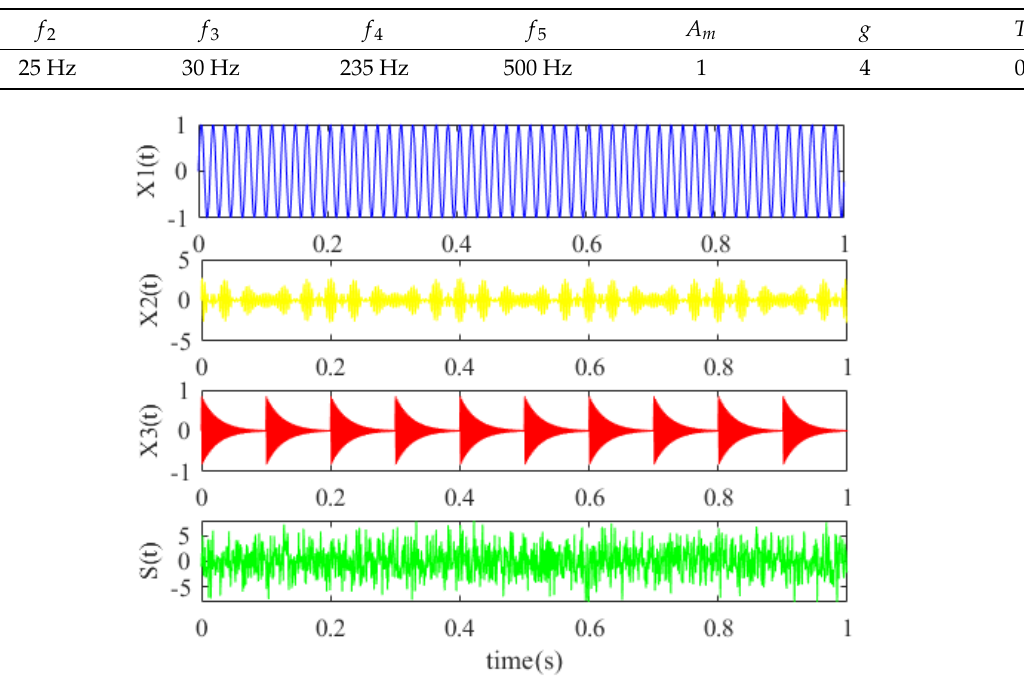
Table 2. The parameter list of the constructed signal.